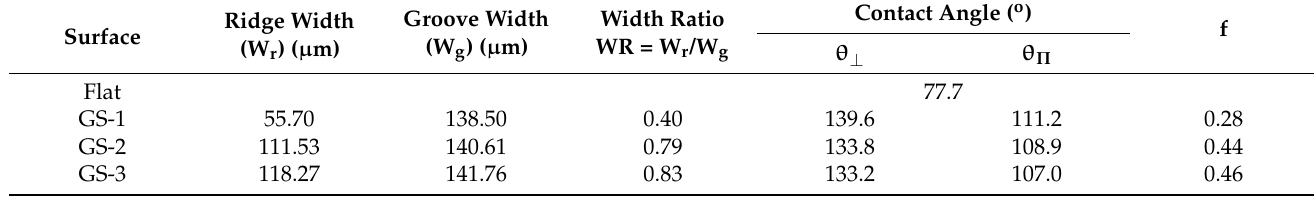
Table 6. Nomenclature, geometrical parameters, width ratio, water contact angles and f values (Cassie-Baxter Equation (1)) of SS304 microgrooves with WR < 1. (data from [6]).